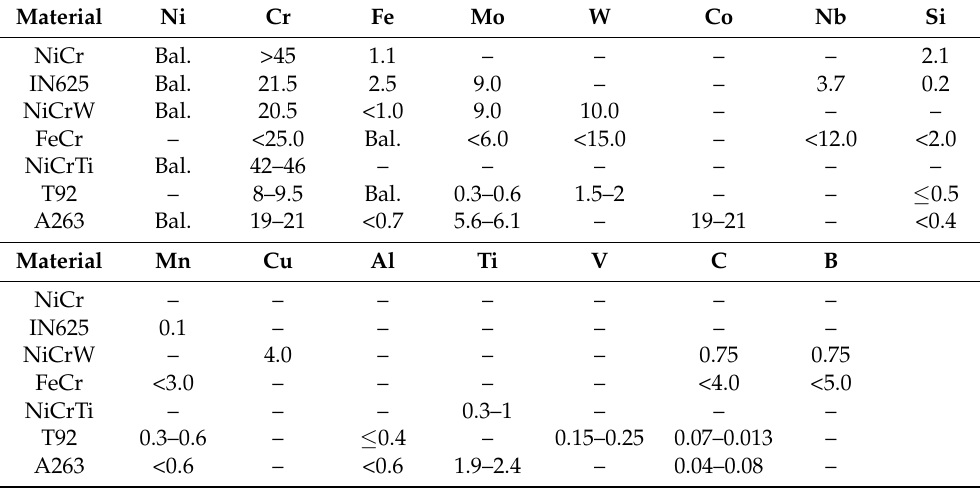
Table 1. Chemical composition of the coating and substrate materials